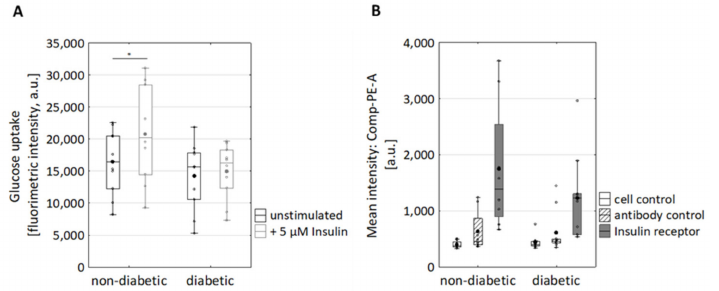
Figure 1. Impact of T2D on glucose uptake and Insulin receptor on the surface of dermal fibroblasts. ( A ) Glucose uptake assay. Fibroblasts from diabetic and non-diabetic donors were grown in starvation medium (DMEM without glucose and FBS) and treated with five µ M insulin. Glucose uptake was analysed in terms of fluorescently labelled 2-( N -(7-nitrobenz-2-oxa-1,3-diazol-4-yl) amino) -2- deoxyglucose (2-NBDG; 100 µ g/mL). * p < 0.05, statistical significance was determined by Mann– Whitney-U-Test between groups and by Wilcoxon text for comparison between untreated and treated subjects; n non-diabetic = 10; n diabetic = 10. ( B ) Expression of the Insulin receptor on the cell surface of diabetic and non-diabetic fibroblasts was analysed using FACS. The cells in the absence of antibodies (=cell control) and cells with isotype antibodies (antibody control) served as controls, antibody against InsR n non-diabetic = 8; n diabetic =